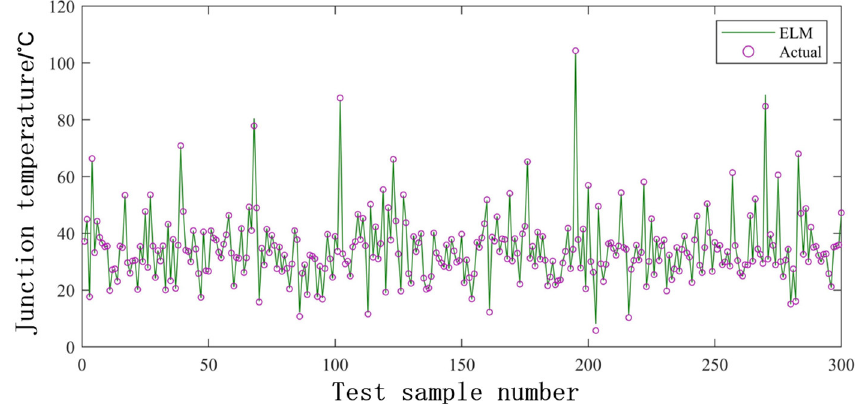
Figure 10. Predicted junction temperature of the SOA-ELM model.